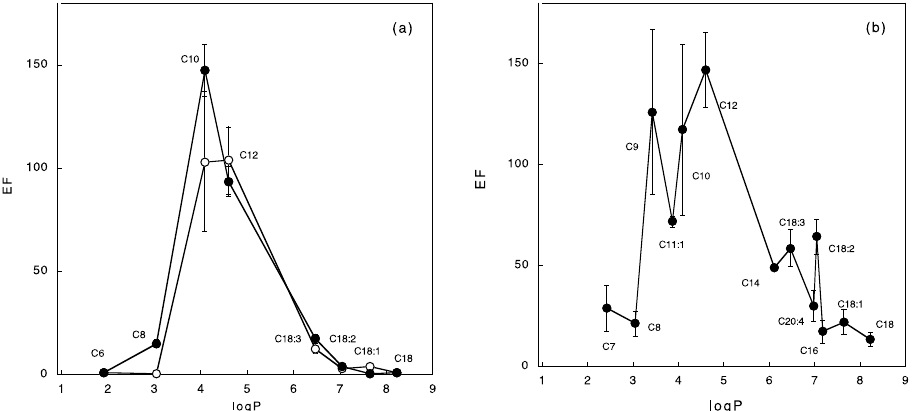
Figure 4. Relationship between fatty acid logP and enhancement factor obtained. Panel ( a ) refers to the present work: empty symbols refer to 5% and full symbols to 10% fatty acid concentration in the pre-treatment solution. Panel ( b ) reports data on naloxone permeation across human skin in the presence of 10% of fatty acids dissolved in propylene glycol [33].